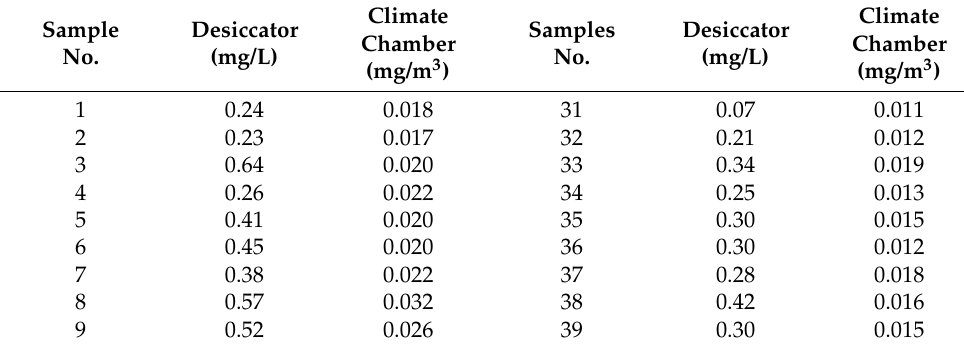
Table 2. The measured results of formaldehyde emission from veneered particleboard by the desicca- tor method and the 1 m 3 climate chamber